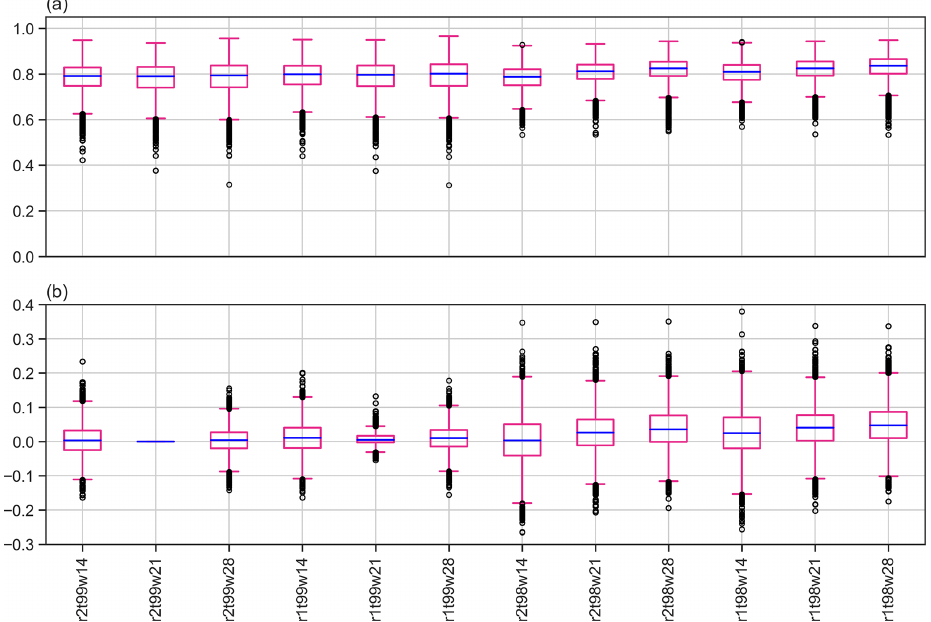
Figure 8. Boxplots of (a) S cont for all catchments and parameter combinations and (b) of the differences in S cont between the initial parameter combination (the second boxplot from the left, i.e. r = 2d, t = 99p, w = 21d) and the other combinations. Boxes extend from the first (Q1) to the third (Q3) quartile values of the data, with a blue line at the median. The position of the whiskers is 1 . 5 × ( Q3 − Q1 ) from the edges of the box. Outlier points past the end of the whiskers are shown with black